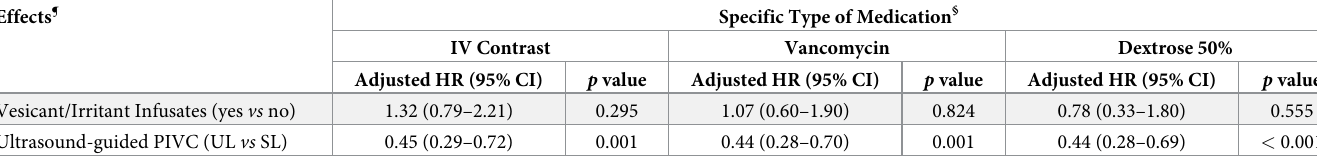
Table 5. Effects of each specific vesicant/irritant infusates on intravenous line failure in separate